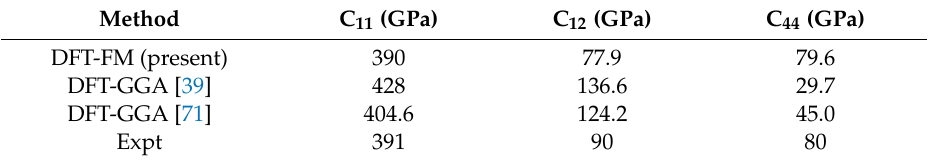
Table 2. Calculated, present, and published [39,71], and experimental [18] elastic constants for